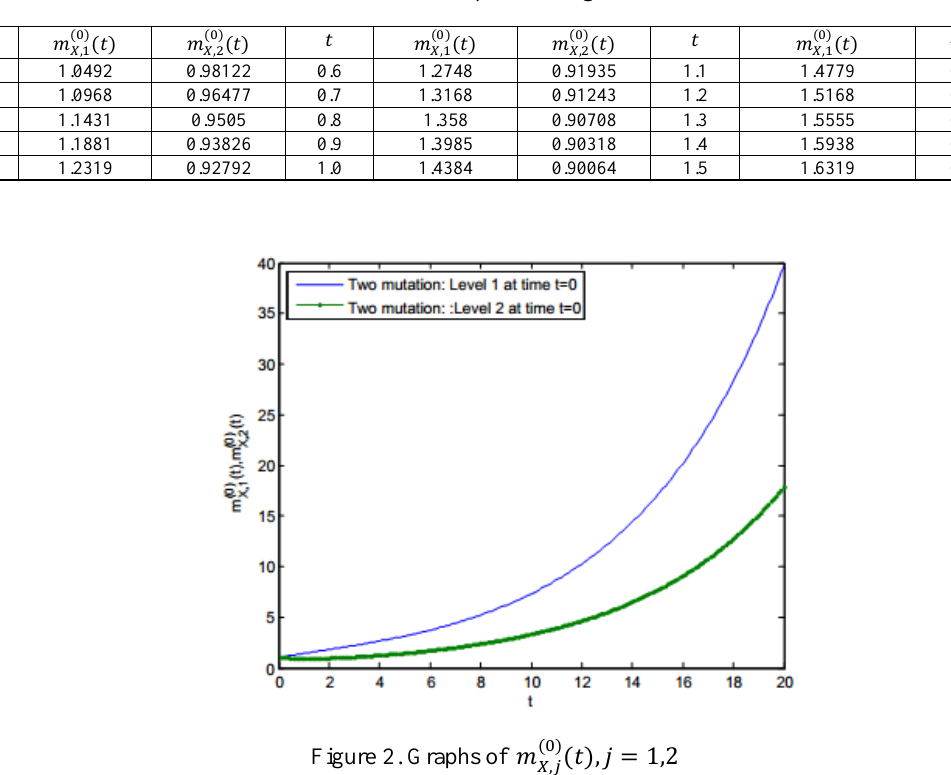
Table 1. Two mutation: comparison of growth of normal cell